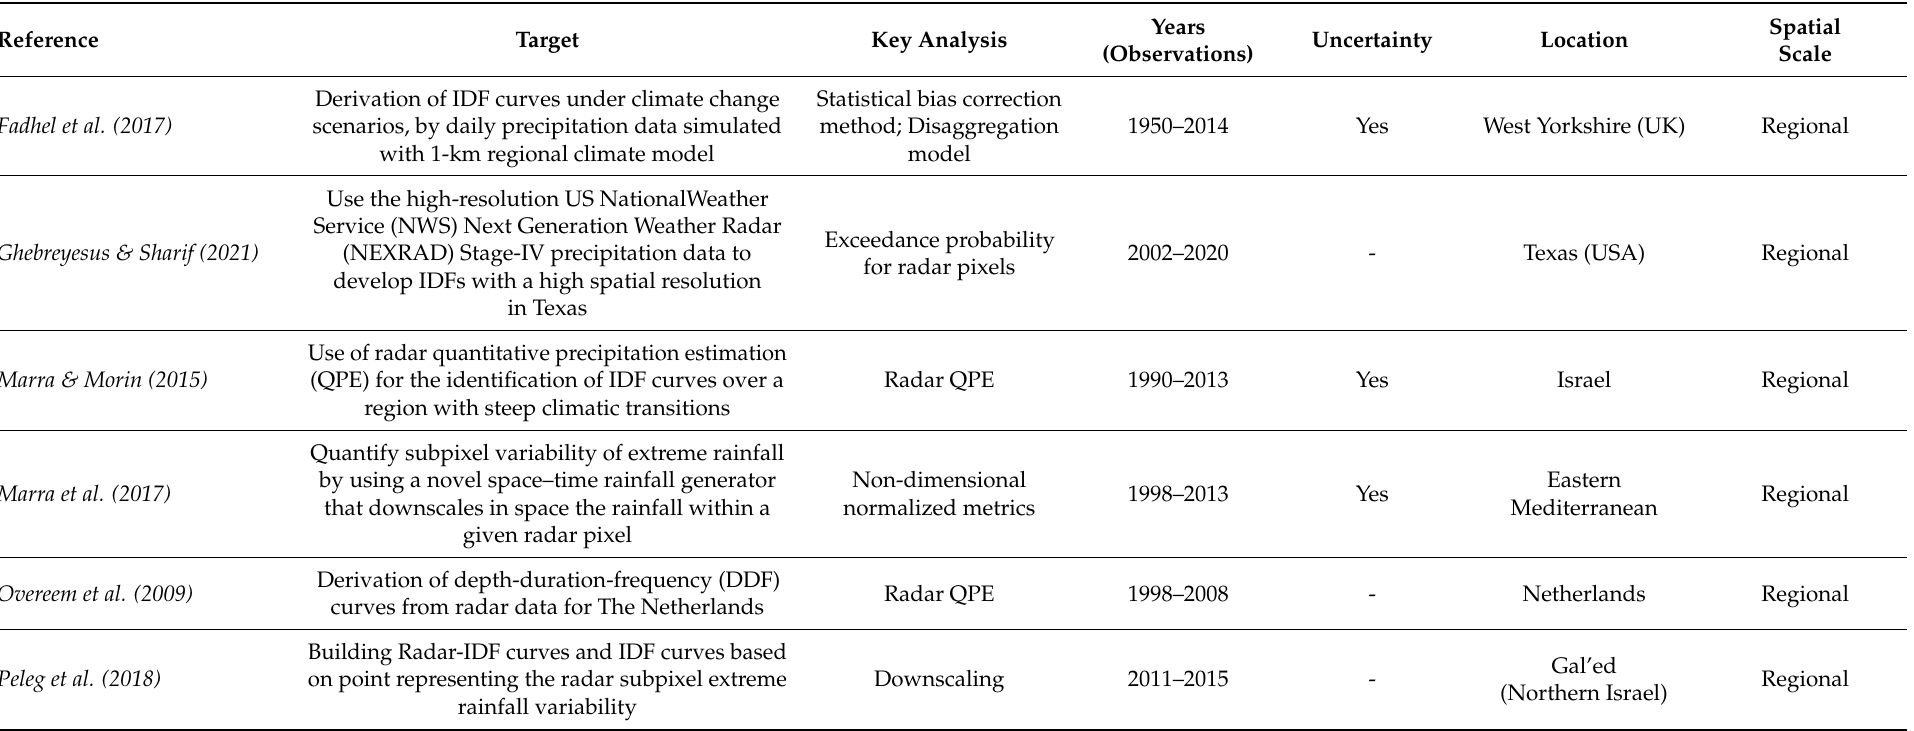
Table 3. Papers developing IDFs using a radar